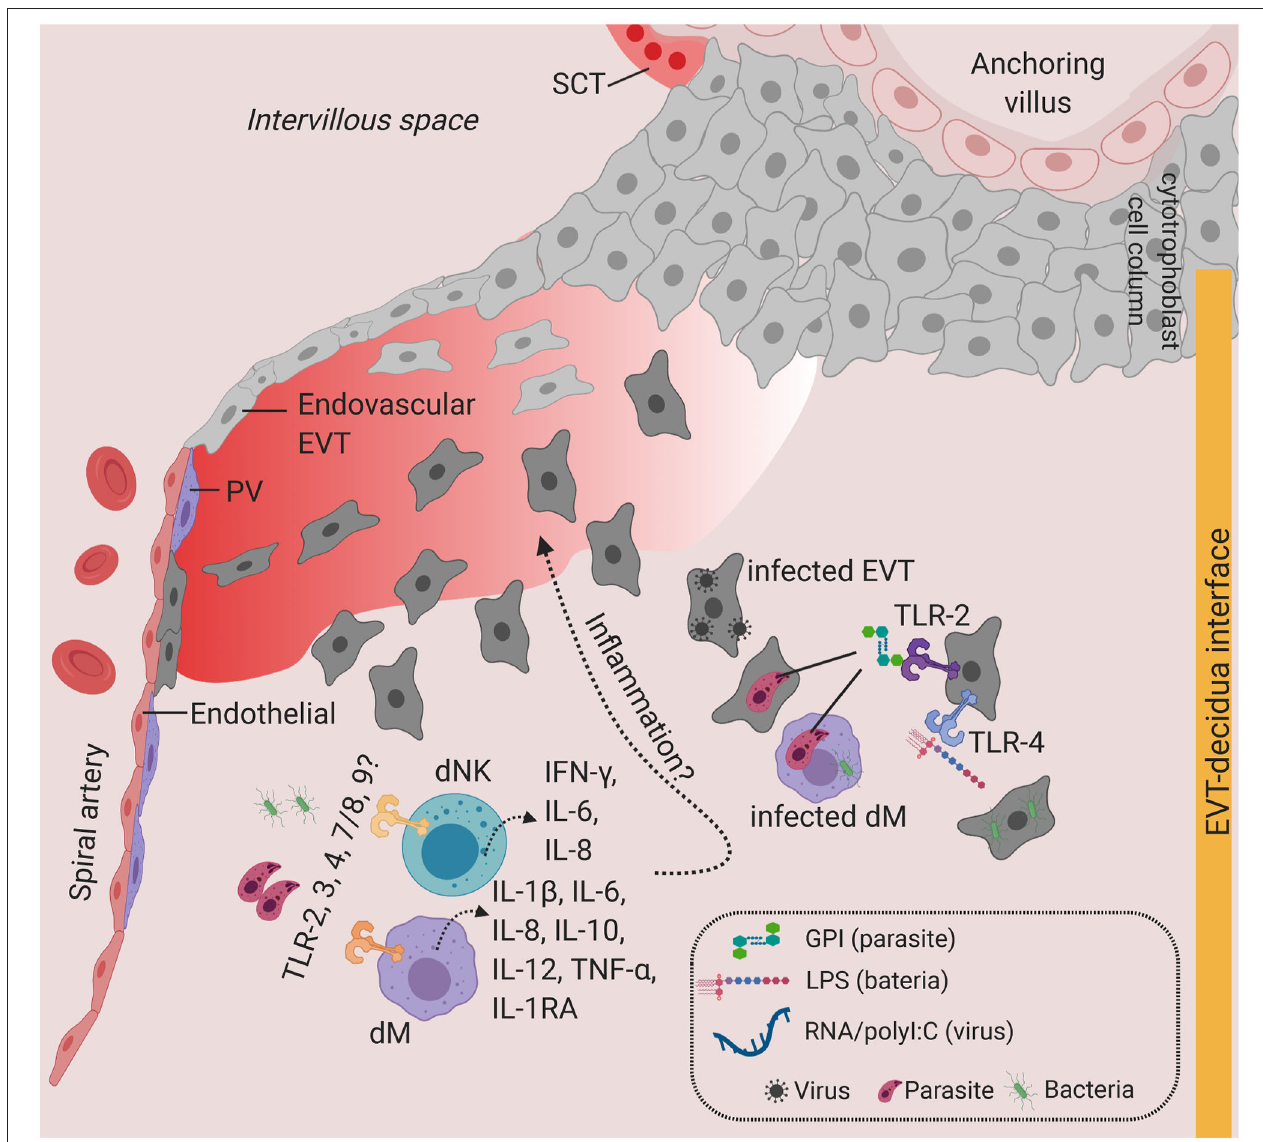
FIGURE 3 | Toll-like receptors and potential inflammatory response at the decidua. Predominant TLRs found in the human placenta from early and term pregnancies. TLR2 and TLR4 are expressed in EVT. dM and dNK also express a wide range of TLR families, where stimulation of TLR agonists lead to the production of a variety of cytokines and chemokines. Infiltration of infected cells and release of PAMPs in the decidua, which will activate TLR-mediated signaling. Overproduction of inflammatory cytokines at the decidua may lead to local inflammation. Figure is created by BioRender.com.